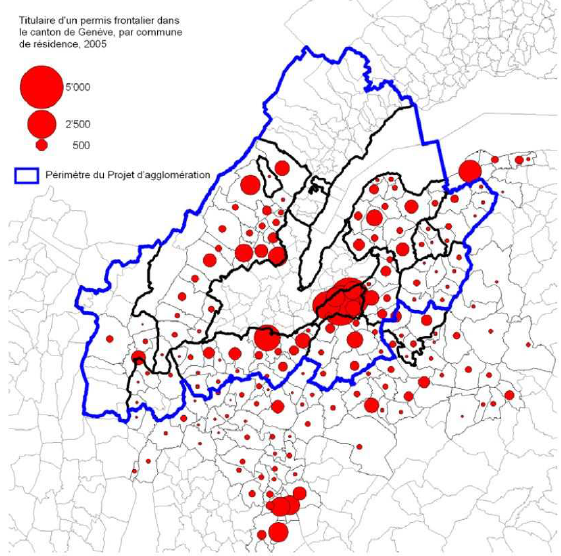
Figure 5. Cross-border commuters in the Genevan agglomeration, in 2000 Legend : repartition of cross-border commuters in 2005 Source : Projet d’agglomération, OCSTAT,